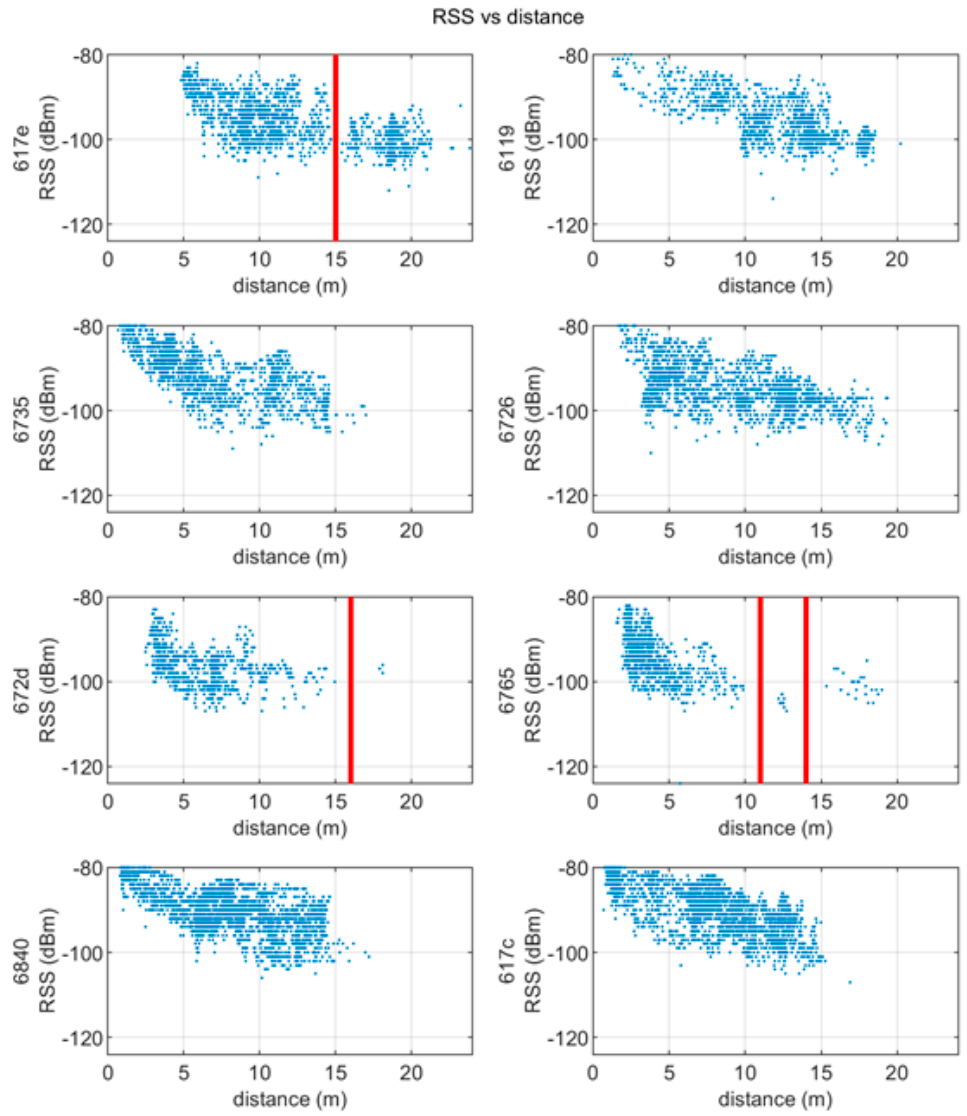
Figure 8. Received signal strength vs. measured distances for each anchor during the pedestrian test. In some plots (in particular for anchors 0x617e, 0x672d and 0x6765) it is possible to observe an interruption in the point cloud representing the power with respect to the distance. As the path is continuous, these interruptions probably correspond to obstacles through which the signal has not